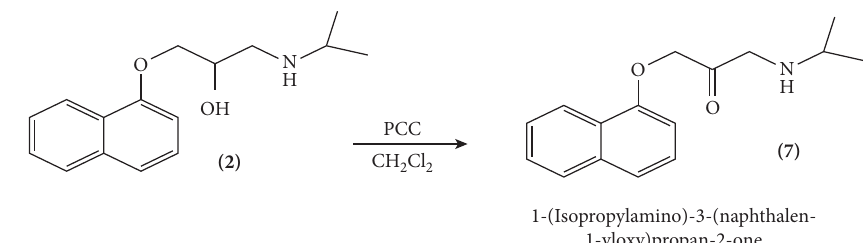
Figure 5: The scheme describes the synthesis process between propranolol and pyridinium chlorochromate in presence of CH for 20h.